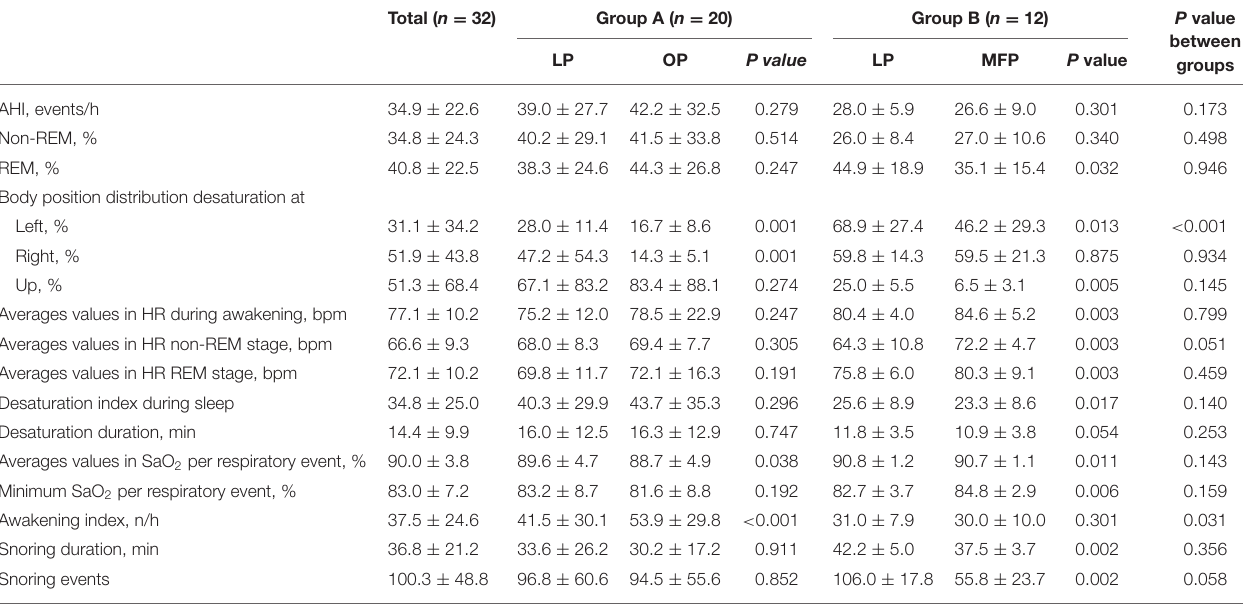
TABLE 2 | Polysomnography parameters results.